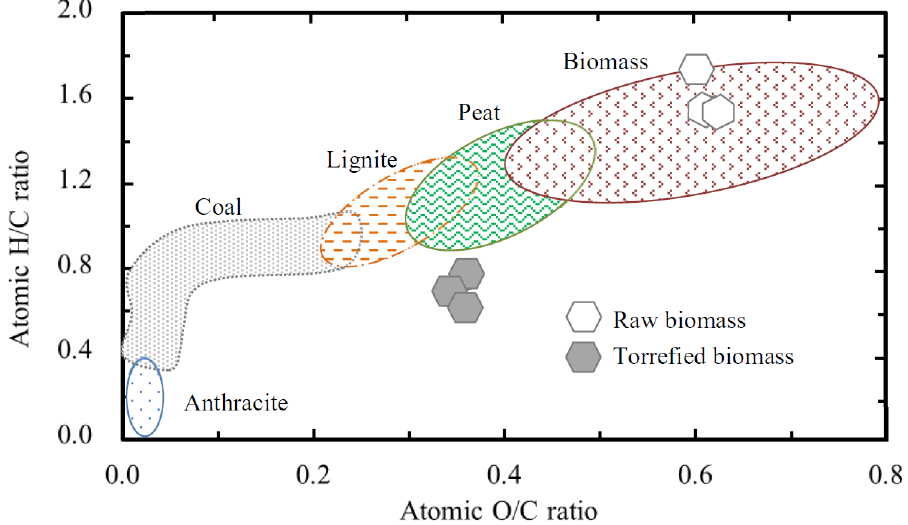
Figure 12. The Van Kravelen diagram shows location of torrefaction products: torrefied straws in diagram in relation to coal and other conventional fuels.